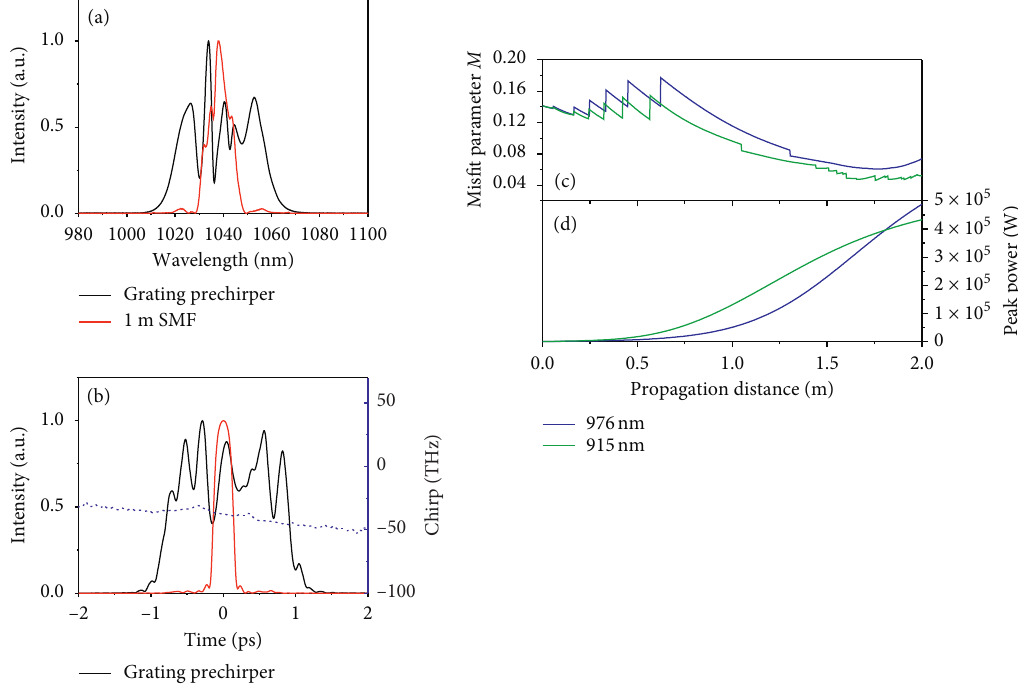
Figure 4: Simulations with (a) the measured spectrums and (b) the PICASO-reconstructed pulses output from the grating prechirper (black solid curve) and the SMF (red solid curve) as the input signal. Amplified pulse evolutions along the fiber under a pump wavelength of 976nm (blue solid curve) and 915 nm (green solid curve): (c) the misfit parameter and (d) the pulse peak power.